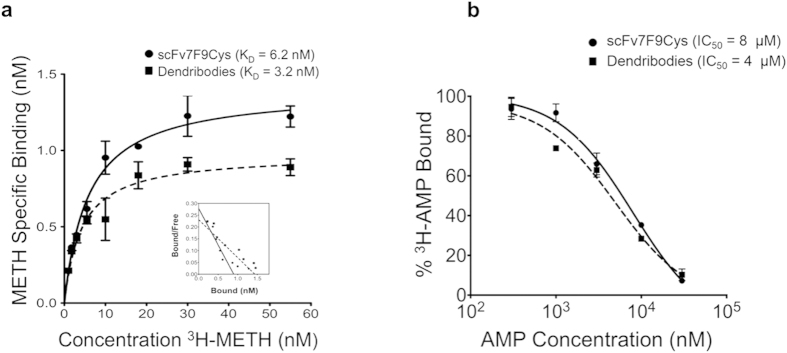
a
In vitro saturation binding data for specific binding of [3H]-METH to scFv7F9Cys and dendribodies with corresponding Scatchard plots (inset). ScFv7F9Cys showed two-fold improvement in affinity for [3H]-METH after conjugation to the dendrimers (p < 0.05). The KD values of the scFv7F9Cys and dendribodies were 6.2 and 3.2 nM respectively. b
In vitro AMP competition binding data of percent [3H]-AMP bound to scFv7F9Cys and dendribodies. ScFv7F9Cys not only retained function but showed a two-fold increase in affinity for [3H]-AMP after conjugation to the dendrimers. The IC50 values of the scFv7F9Cys and dendribodies were 8 and 4 μM respectively. Data points are the mean ± SEM of triplicate determinations.